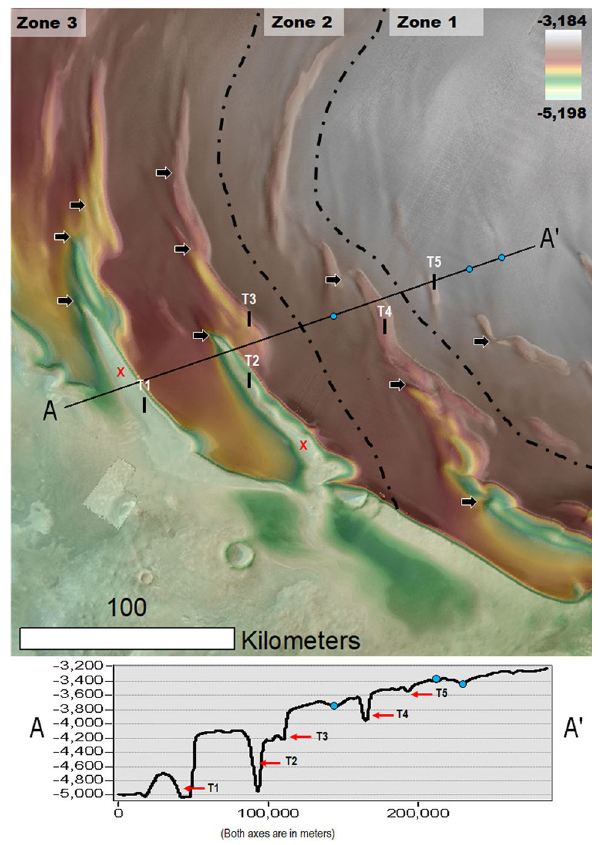
Figure 5. View of PB centered at 81° 38’ N, 14° 30’ W with a succession of stair-step trough topography (elevation profile), which exhibits increasingly wider, deeper, and more longitudinally extensive spiral arms. Note that we identified the troughs (T1-T5) and undulations (blue dots) situated along the elevation profile’s path. The two red “X” letters identify zones where the trough floors expose the VBF (i.e., the northern plains unit, which in this region underlies the NPLD). Despite the troughs’ topographic and spatial complexity, we find their overall morphologic characteristics reflect varying degrees of development, which broadly fit within our proposed three zonal categories: (1) PB areas where relatively small troughs form sparse clusters (Zone 1). (2) Areas where trough junctures reflect widespread intersection relationships which are spatially manifested as continuous spiral arms. In these areas, the troughs have floors excavated within the NPLD (Zone 2). (3) Areas where these spiral arms are longer and deeper, are closely spaced, and expose geologic surfaces that underlie the NPLD. In the context of this figure, the exposed surfaces are part of the VBF (Zone 3). The dashed lines demark the contacts between Zones 1 & 2 and 2 & 3. All these zones retain a common baseline morphologic attribute – the preservation of inter-cell ridges (black arrows). This observation is consistent with these spatial zones, broadly reflecting the temporal sequence of trough development and spiral pattern generation. In Fig. 6, we graphically present this proposed protracted history of cell enlargement, intersection, and merging leading to the formation of the spiral arms. Our reconstruction in Fig. 6A is based on the spiral arm connecting troughs T2 and T3. We produced this figure using Esri’s ArcGIS 10.3 (http:// www. esri. com/ softw are/